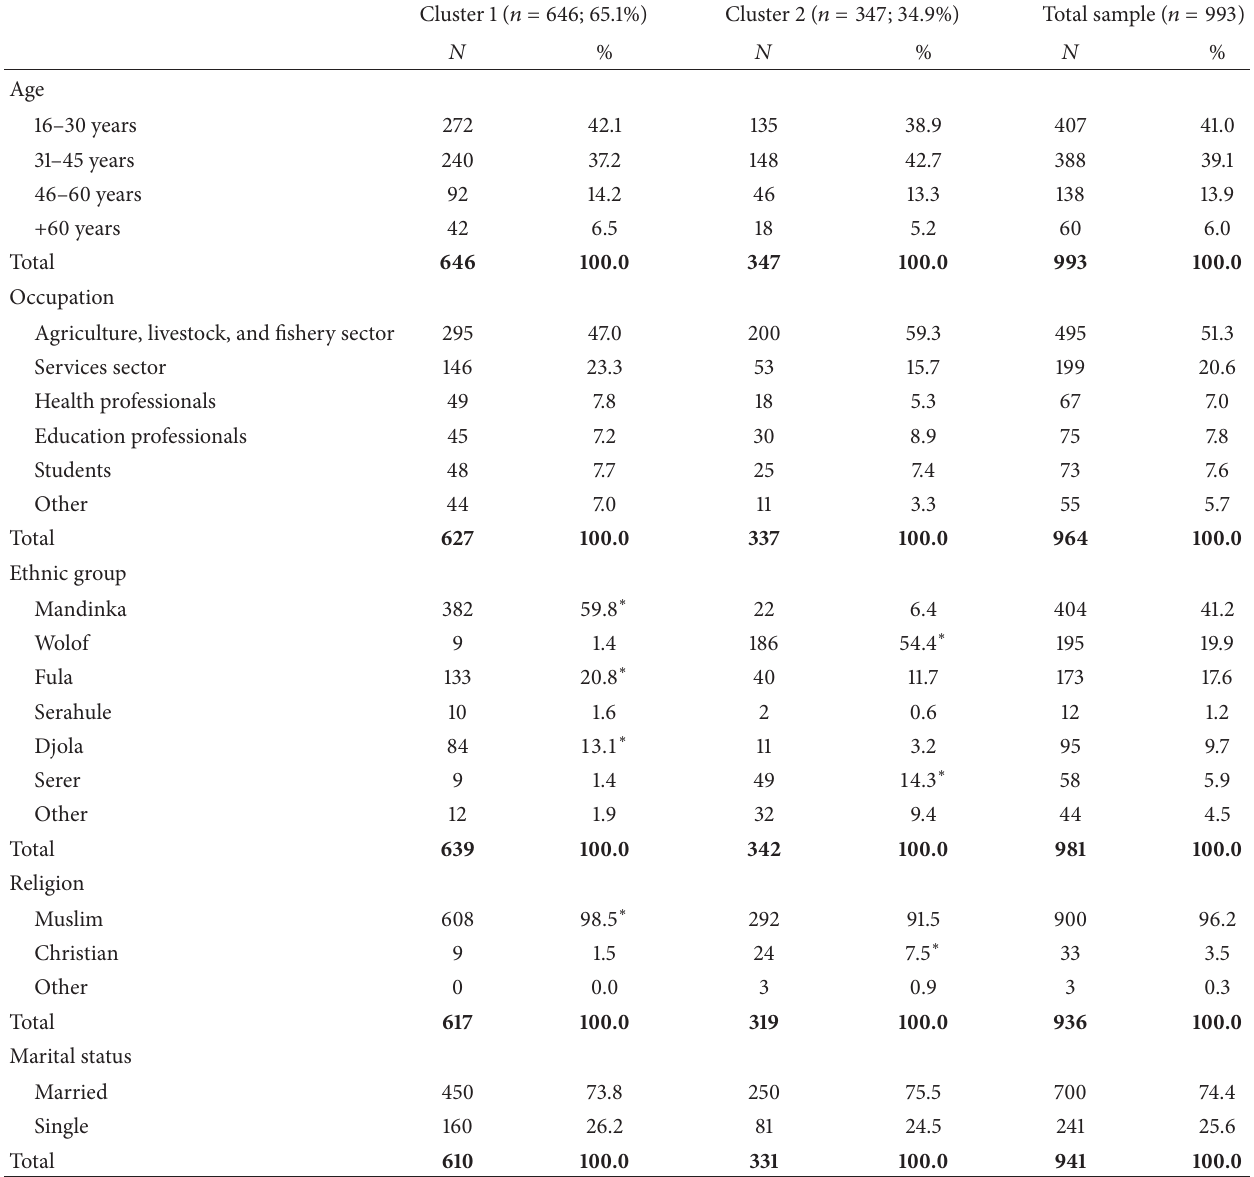
Table 5: Socio-demographic description of sample and